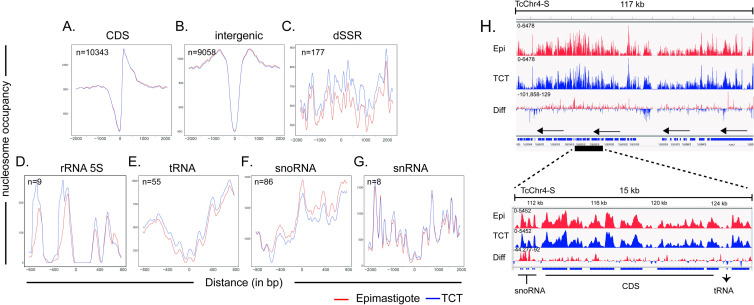
Nucleosomal occupancy among gene classes and features for epimastigotes (red) and trypomastigotes (blue).A-G. Occupancy levels were obtained by DANPOS2 using kb ranges (at x axis) for each gene class/feature. The number of elements used for each plot is shown. For dSSRs, landscapes were built from the center region. All other classes, the zero (x axis) represents the first nucleotide for the corresponding gene. Evaluation of occupancy overlap and a Tukey test from distance values obtained from epimastigote and TCT landscapes point by point are shown in S10 Fig. H. IGV representation of DANPOS nucleosome peaks highlighting snoRNA, CDS and tRNA regions at TcChr4-S.